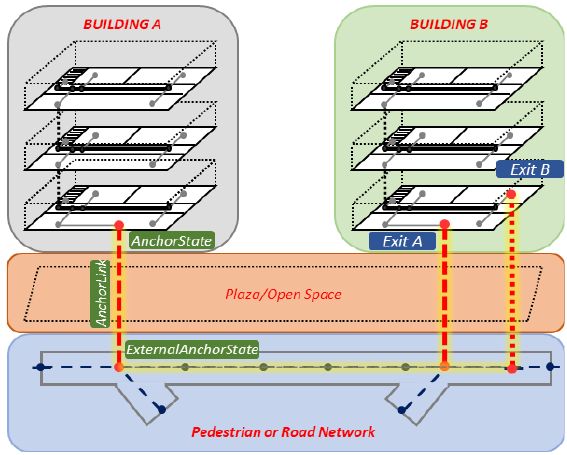
Figure 8 . The connection between indoor and outdoor navigation networks using the SeamlessNavigation module